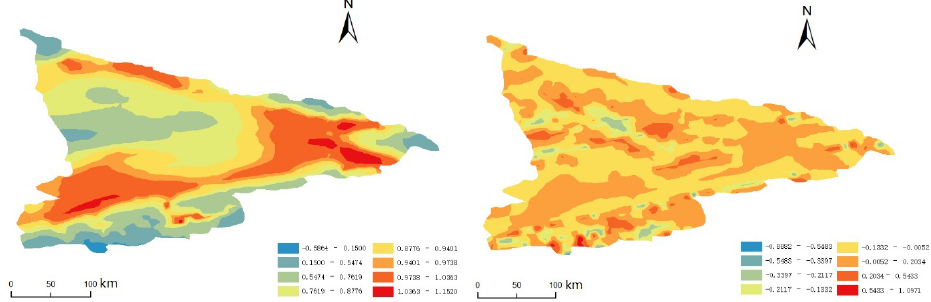
Figure 5. The estimation of the FVC with the adaptive bandwidth matrix H ( left ) and the residu- als ( right